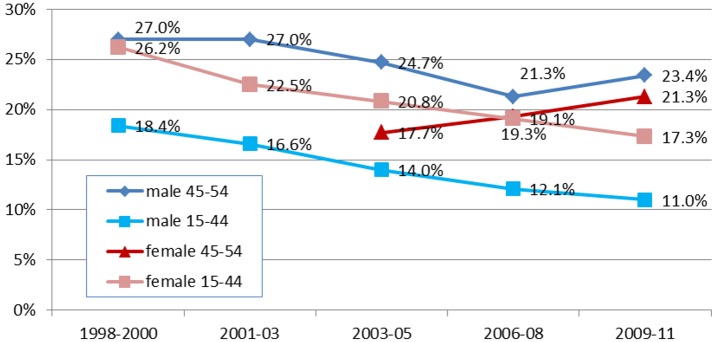
Comparison of trends in HIV prevalence among men and women aged 45–54 years and 15–44 years, by survey round.